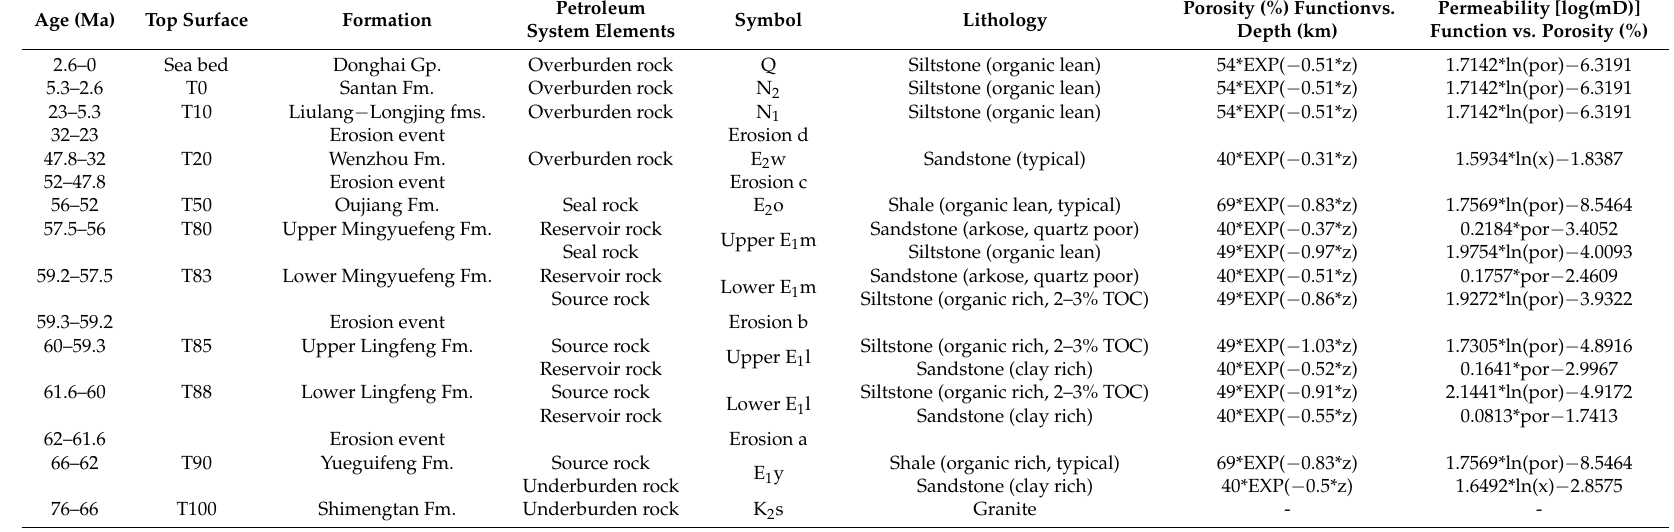
Table 1. Lithology settings and petrophysical definitions for basin modelling. Gp. = Group, Fm. = Formation, fms. = formations, z = depth, por = porosity. The Mingyuefeng Fm., Lingfeng Fm. and Yueguifeng Fm. each has two lithology types, the distribution of the different lithology types are shown in Section